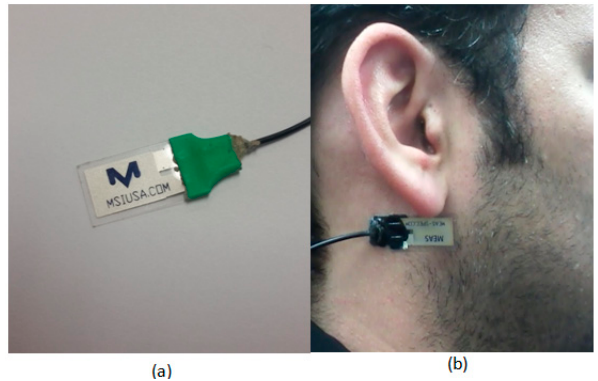
Figure 1. ( a ) Piezoelectric film sensor used in the study; ( b ) Sensor attached to a